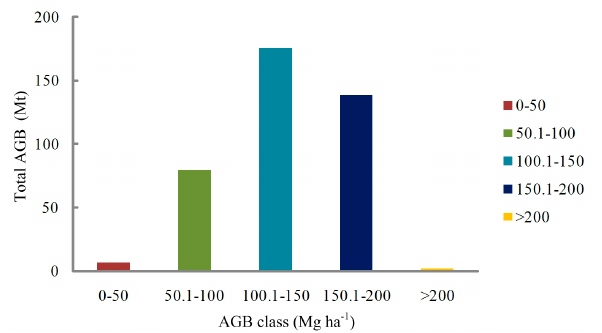
Figure 5. Distribution of forest AGB from AGB predicted map in five classes. Remote Sens. 2017 , 9 , 707